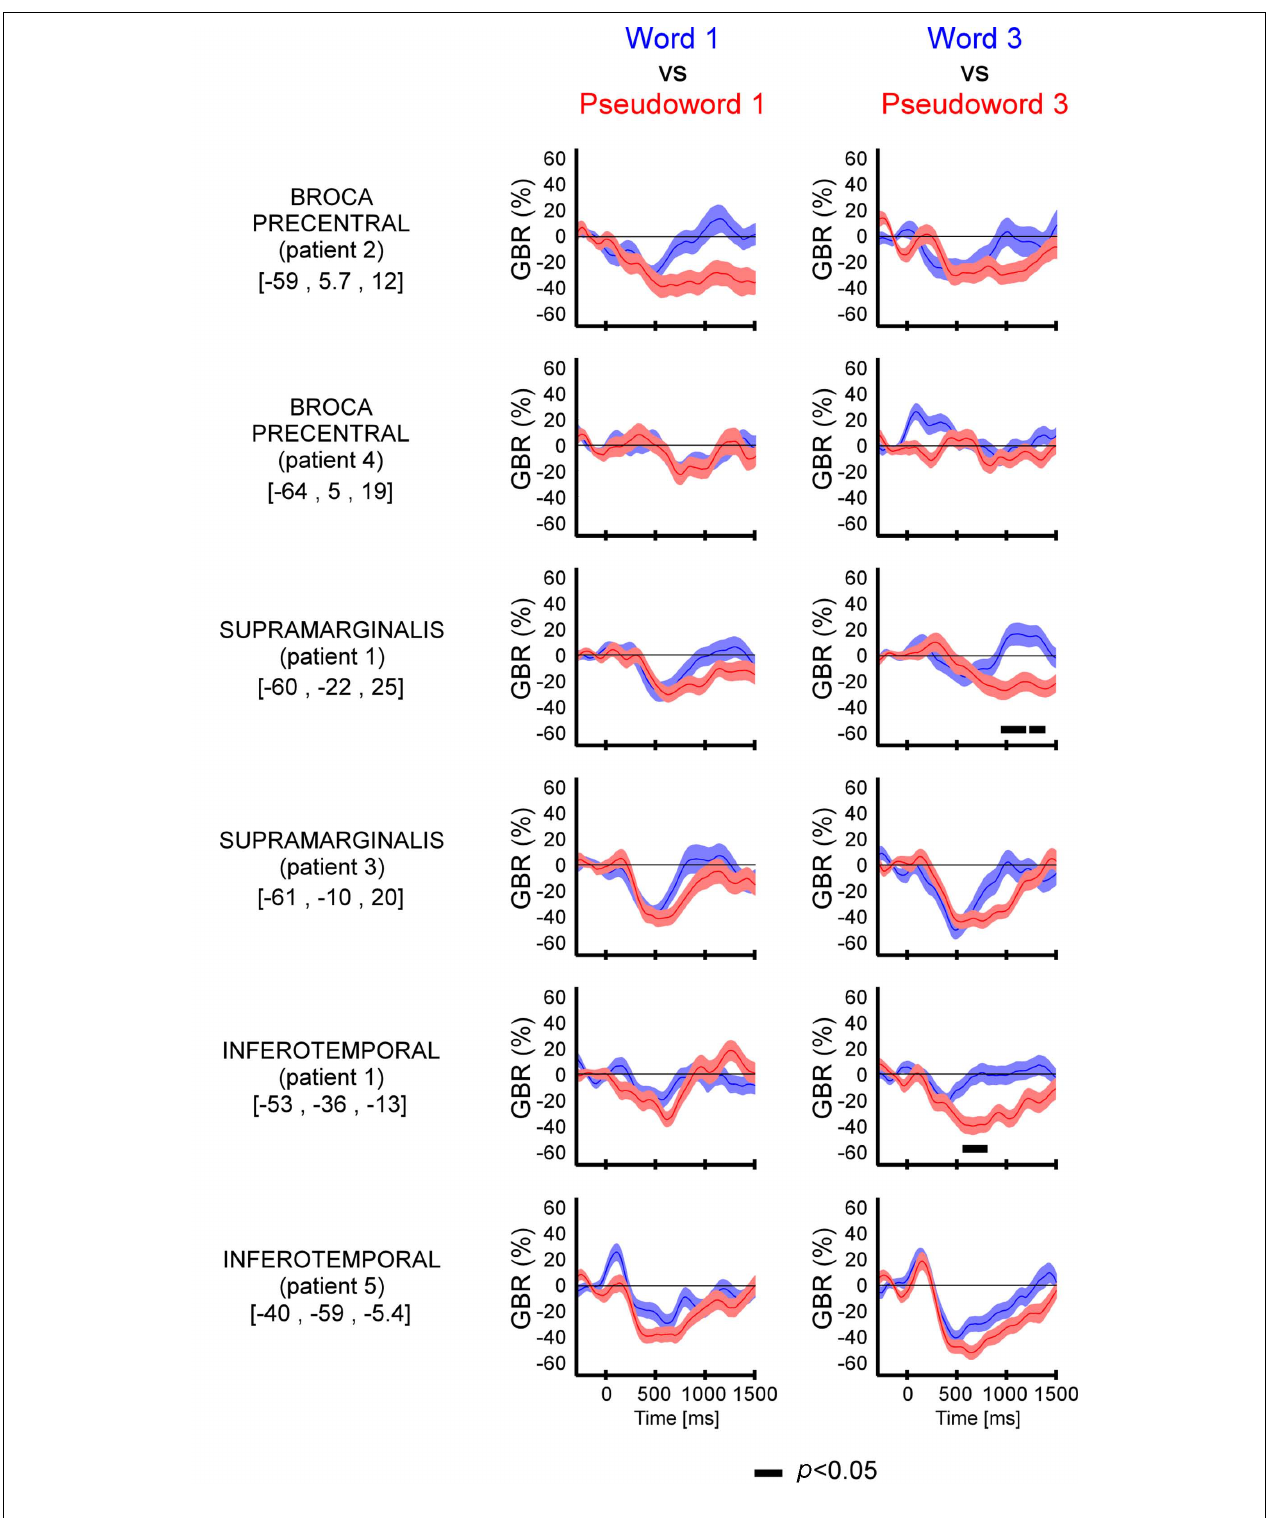
corrected for multiple comparisons). Only for patient 1 there was a significant difference in alpha-band response when comparingWord 3 vs. Pseudo-word 3. All other patients show no lexicality effect. For each region theTalairach coordinates are